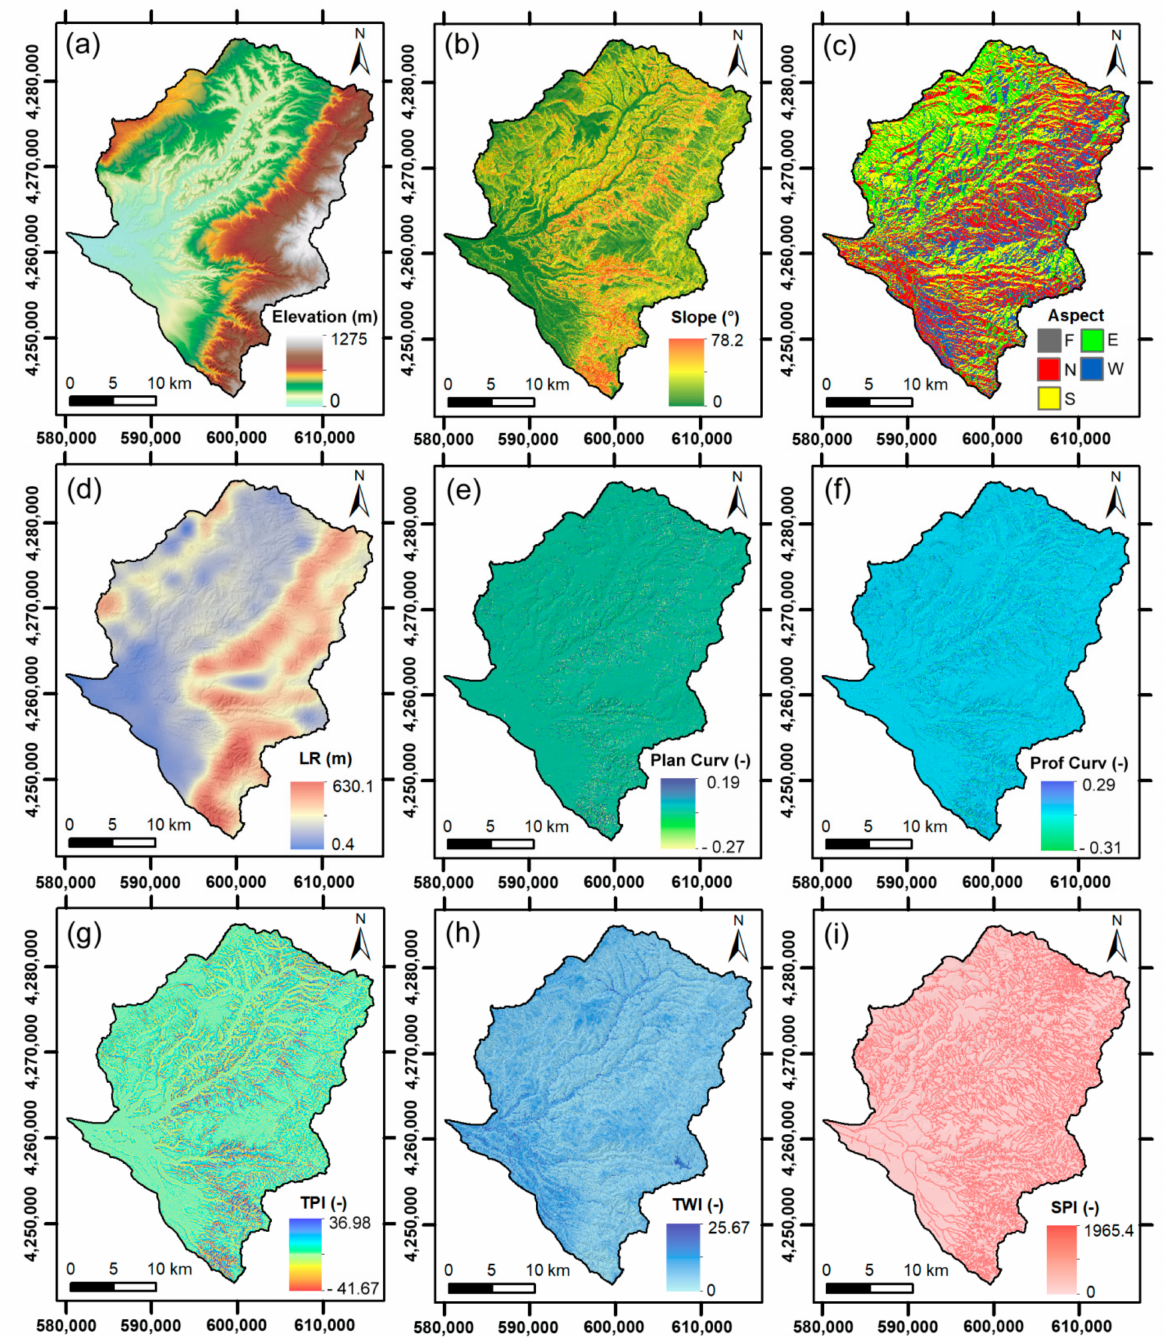
Figure 5. ( a ) Elevation map; ( b ) slope gradient map; ( c ) slope aspect map; ( d ) local relief map; ( e ) plan curvature map; ( f ) profile curvature map; ( g ) TPI map; ( h ) TWI map; ( i ) SPI